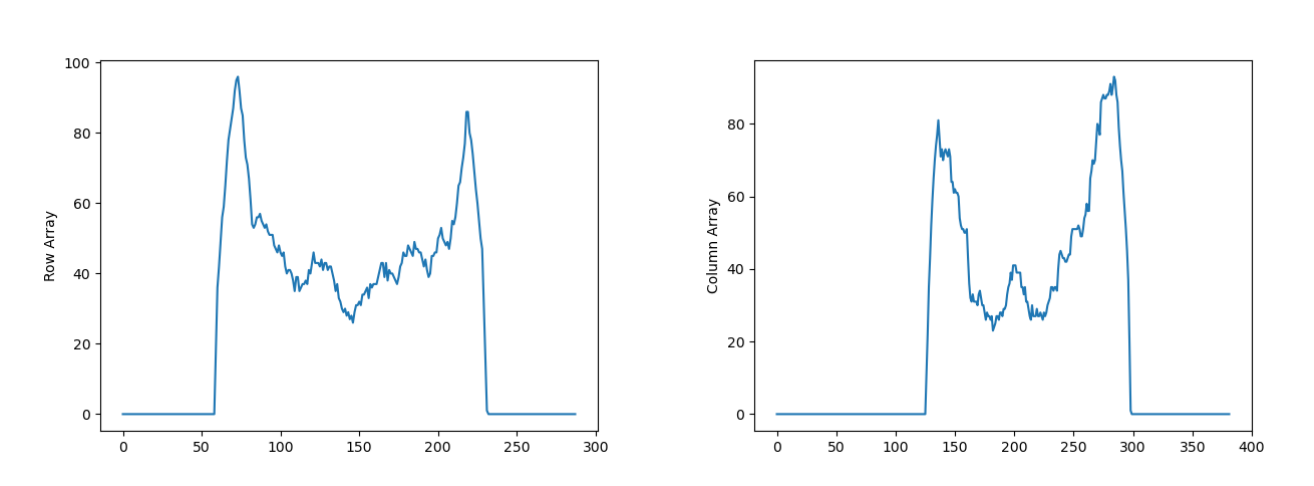
Figure 12. Signature of the incorrectly predicted image.